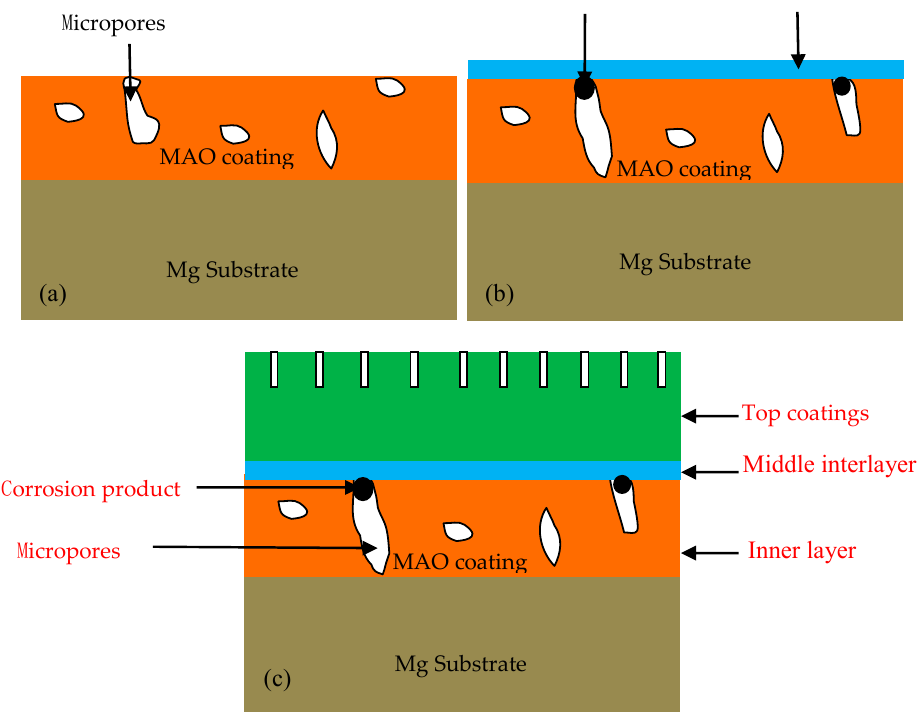
Figure 8. Schematic diagrams of the immersion corrosion of MAO–Cu 2 P 2 O 7 coating in the artificial seawater. ( a ) Morphology of MAO coating before corrosion, ( b ) Morphology of MAO coating at the initial stage of corrosion, ( c ) Morphology of MAO coating at the latter stage of corrosion.